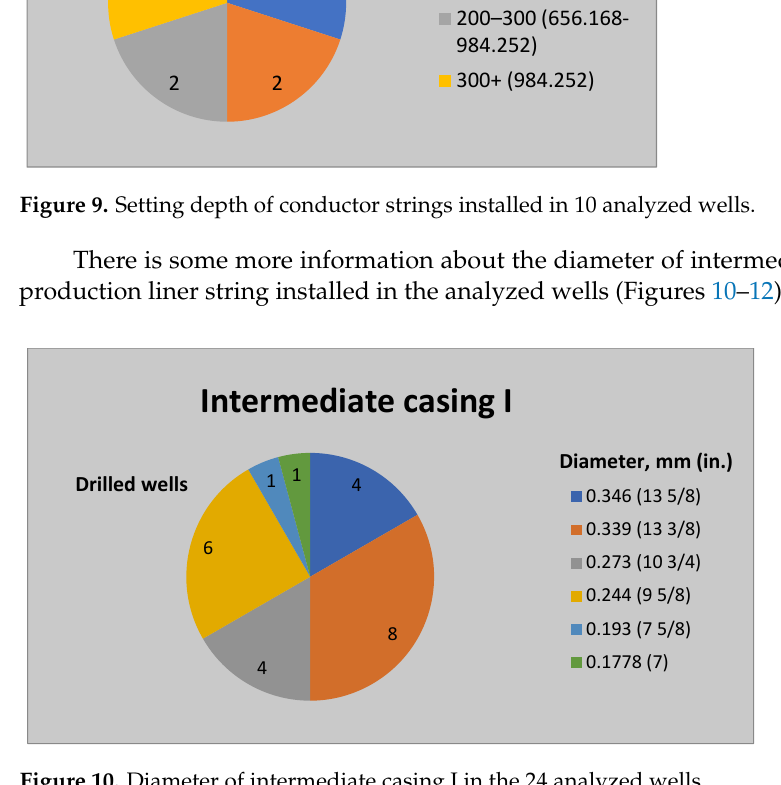
Figure 11. Diameter of intermediate casing II in 8 analyzed wells. Figure 12. Diameter of production casing/production liner in 21 analyzed wells. Data presented in Table 3 show the technical information for intermediate casing I for 24 wells, where most of the wells have an intermediate casing of 339.725 mm (13 3/8 in.) and 346.075 mm (13 5/8 in.) in diameter. Figure 10 shows the diameter of the